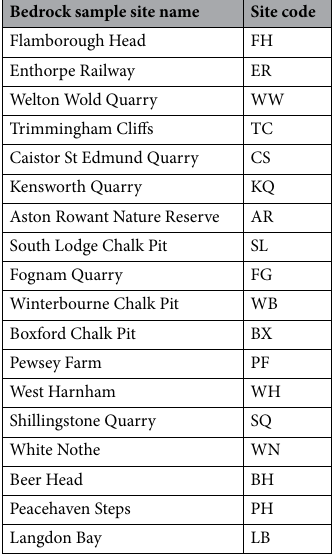
Table 1. Table listing bedrock geological sample sites used in this research (based on Elliot